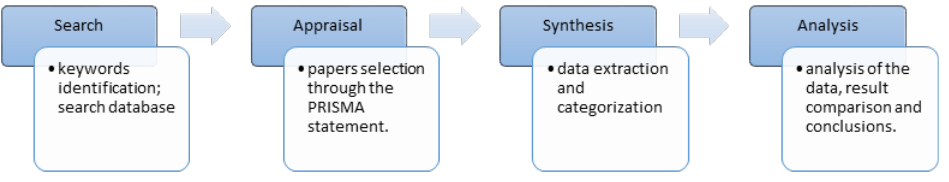
Figure 2. Framework for systematic literature search and review.